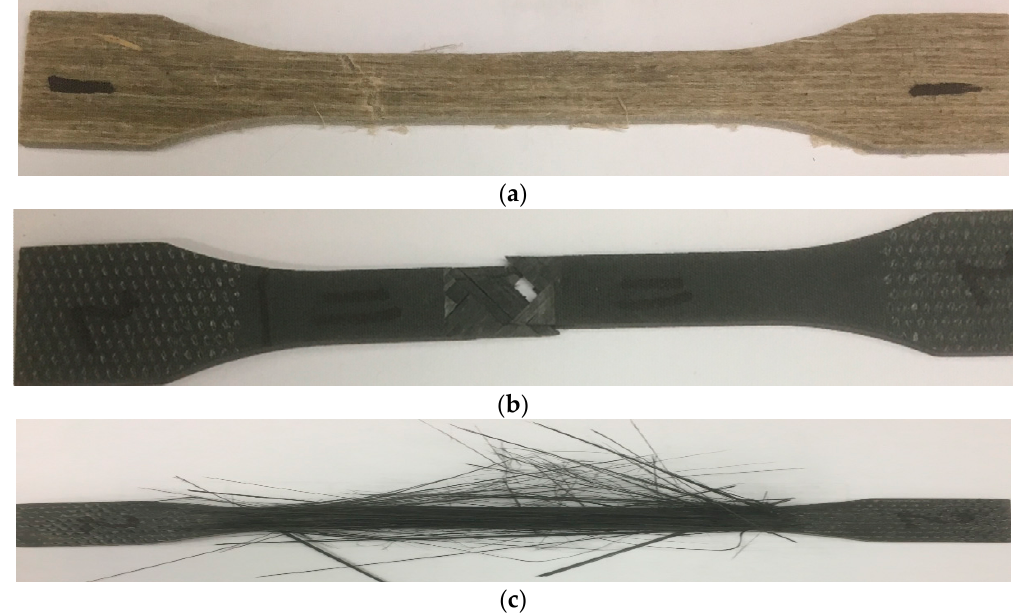
Figure 5. Representative tensile test specimens failed under tensile loading ( a ) plain UD flax/epoxy, ( b ) plain UD carbon/epoxy, and ( c ) UD carbon/flax hybrid composite. Abbreviations: UD, unidirectional.